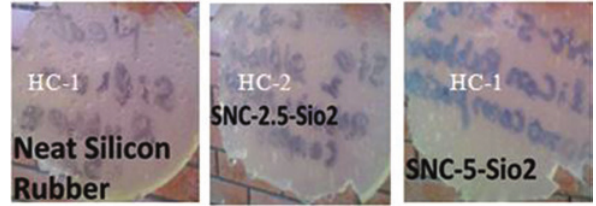
Figure 5: Photographs taken after 5000 h for STRI hydrophobicity